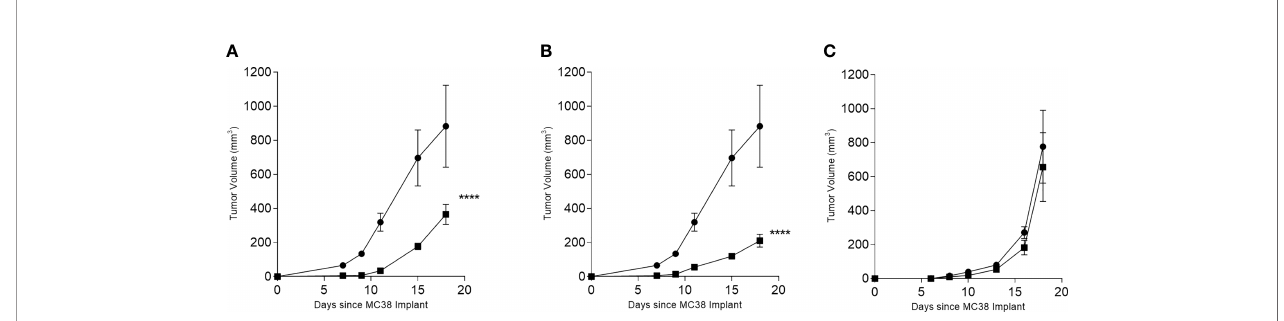
FIGURE 3 | INF- g -inducing peptide-based vaccines derived from CDC25B or COX2 inhibit the growth of MC38 in vivo . Mean ( ± SEM) tumor volume (mm 3 ) in multi- peptide immunized mice ( ▪ ) or PBS immunized mice ( ● ) for (A) CDC25B peptide mix, (B) COX2 peptide mix and (C) RCAS1 peptide mix. ****p < 0.0001, n = 4-8